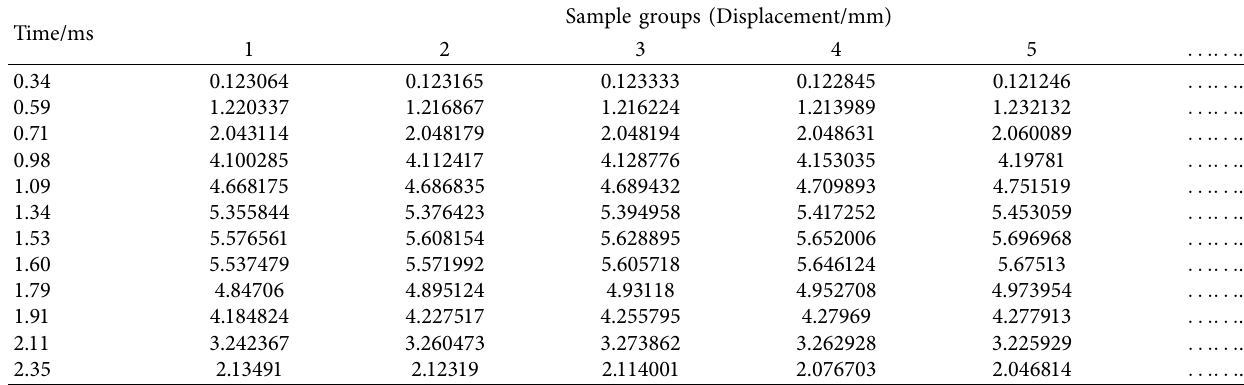
Table 7: Sample groups.